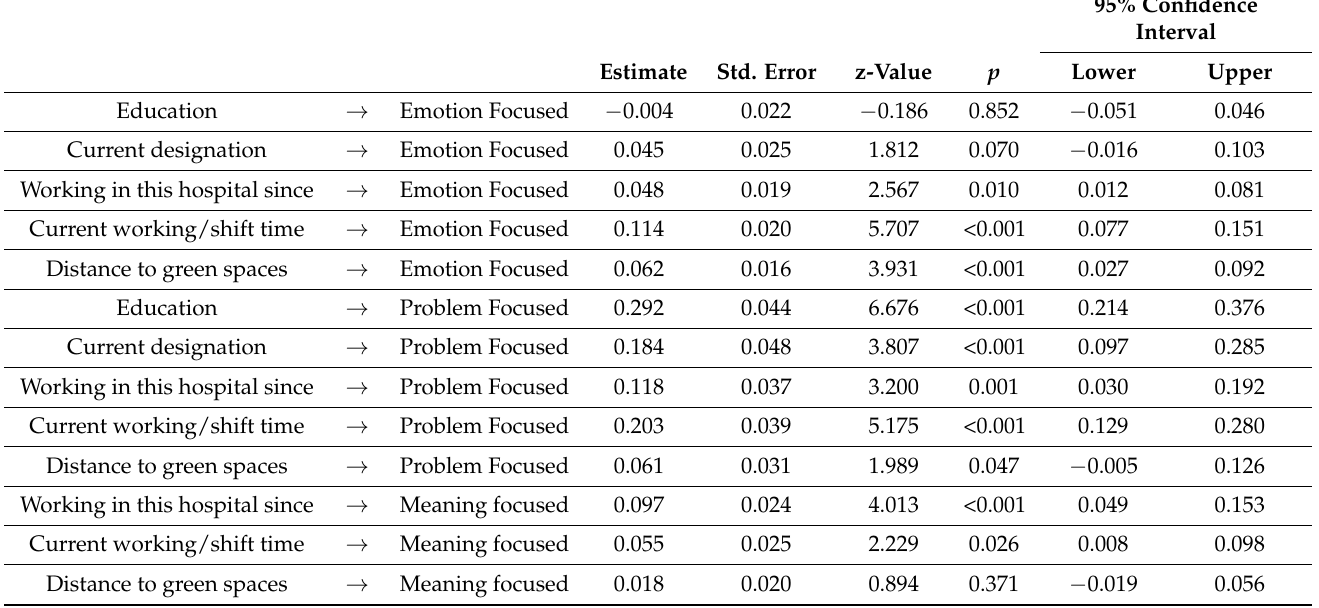
Table 3. Total effects of demographics on